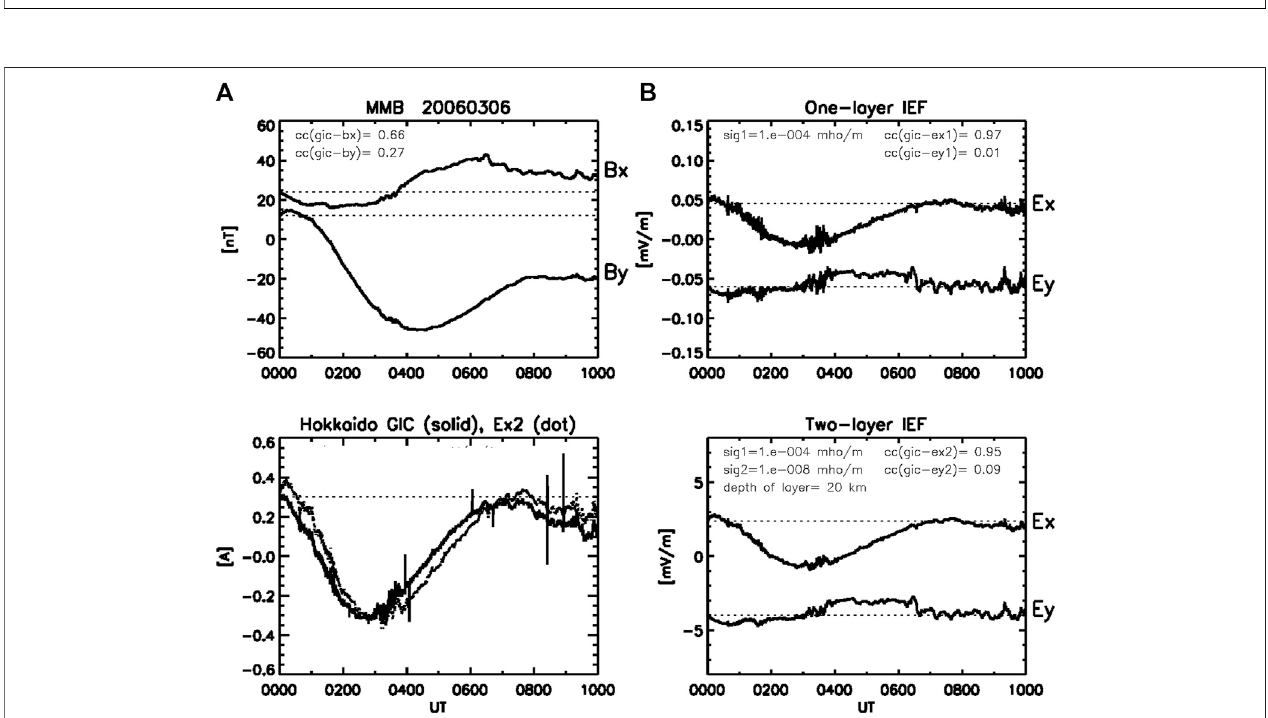
FIGURE6|(A) B x , B y andGICobservedatMMB,and (B) E x and E y calculatedintheone-andtwo-layermodelsforthesolarquietdiurnalvariationswithtimescales of 8 h (00-08 UT, 09-17 MLT). The parameters and formats of the plots are the same as in Figure 1 .